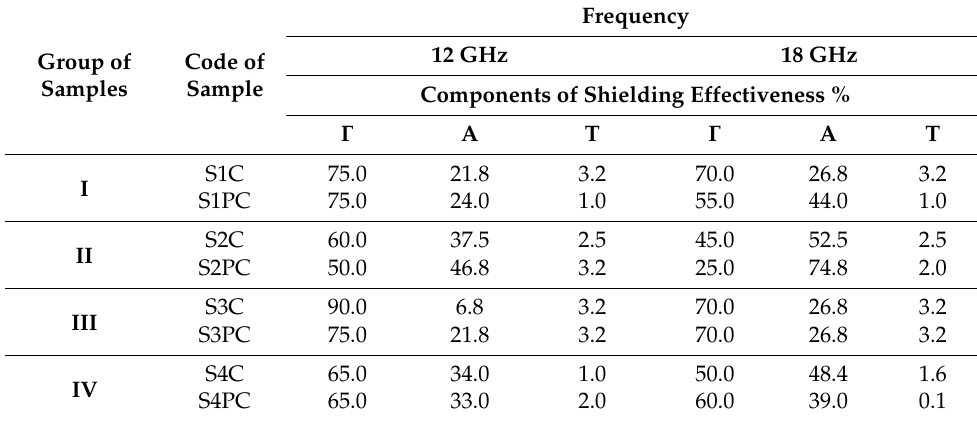
Table 6. Microwave properties of tested coated fabrics.